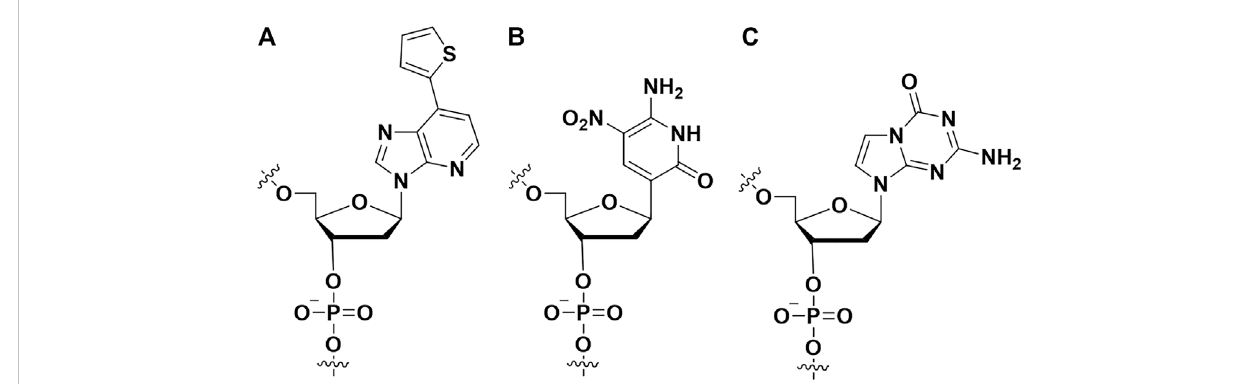
FIGURE 7 The arti fi cial nucleotides incorporating into aptamer to improve binding af fi nity. (A) The (7- (2-thienyl) imidazo [4, 5-b] pyridine) (Ds) arti fi cial nucleotide; (B) the 6-amino-5-nitro-3- (1 ′ - β -D-2 ′ -deoxyribofuranosyl)-2 (1H)-pyridone (Z) arti fi cial nucleotide; (C) the 2-amino-8- (1 ′ - β -D-2 ′ -deoxy- ribofuranosyl)-imidazo-[1,2-a]-1,3,5-triazin-4 (8H)-one) (P) arti fi cial nucleotide.